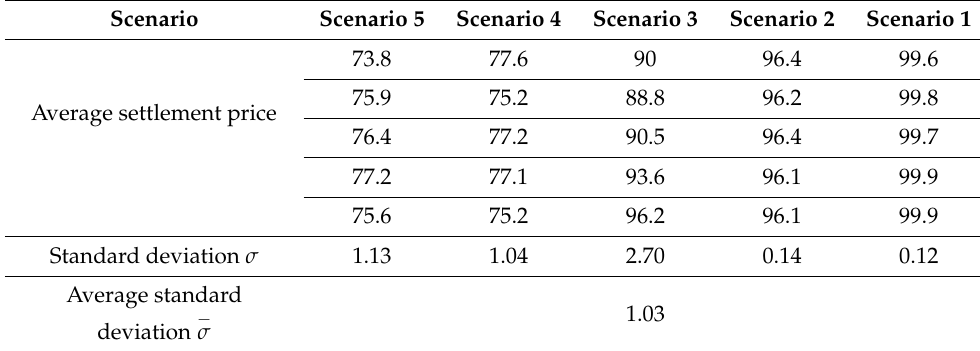
Table 8. The average clearing price for the five times under the PAB pricing